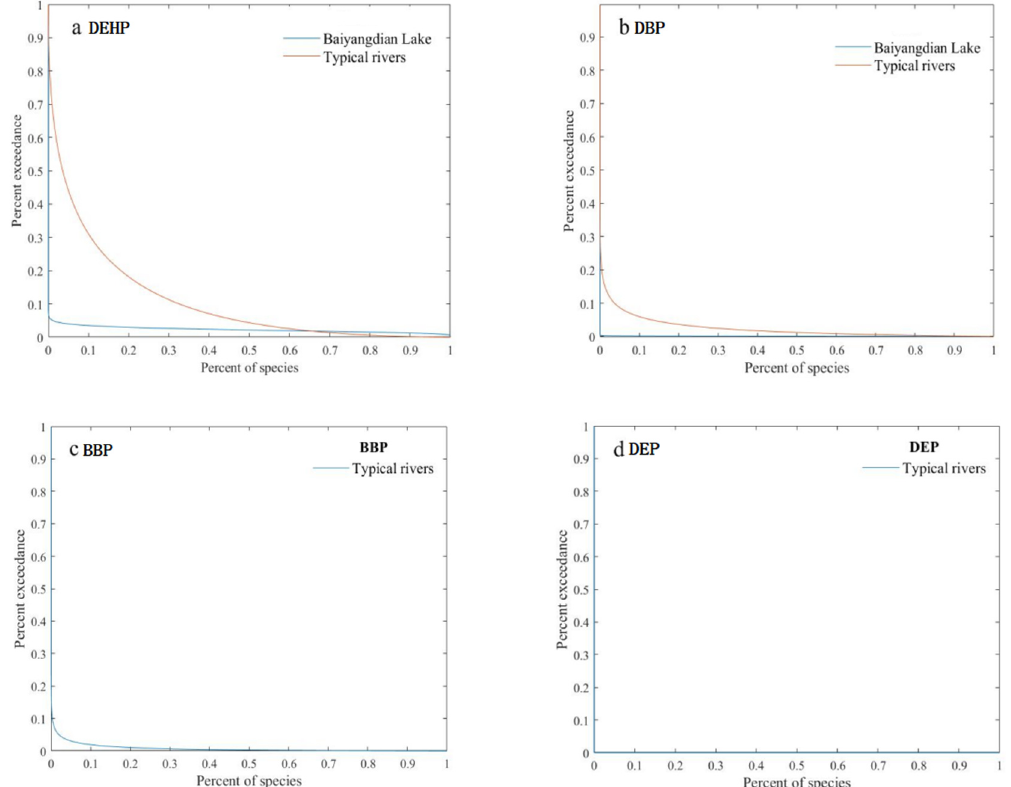
Figure 4. Joint probability curves for ecological risks of PAEs. ( a ) Joint probability curve of DEHP; ( b ) Joint probability curve of DBP; ( c ) Joint probability curve of BBP; ( d ) Joint probability curve of DEP).